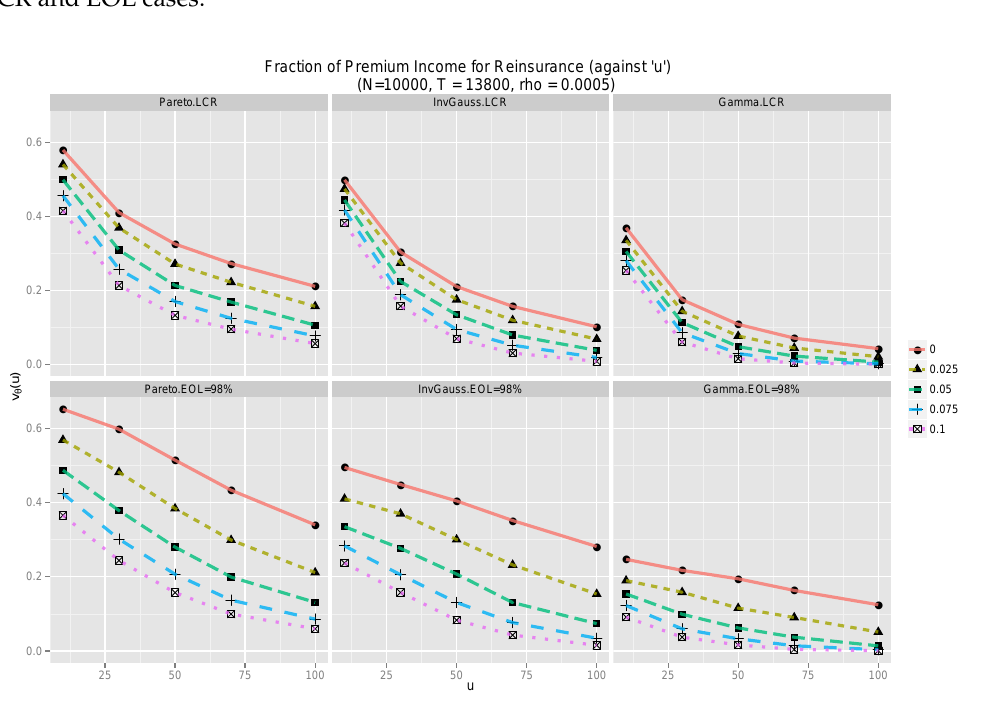
Figure 6. v θ ( u ) (from (32)) is the proportion of the dividend available to pay for reinsurance without reducing the value of the firm. For Pareto, Inverse Gaussian and Gamma claim distributions, initial reserve levels u = 10, 30, 50, 70, 100, time value of money ρ = 0.0005, and safety loadings θ = 0, 0.025, 0.05, 0.075, 0.1. Top panel: LCR; bottom panel, EOL with L taken as the 98th percentile of the claims distribution. Simulations are done with N = 10,000 sample